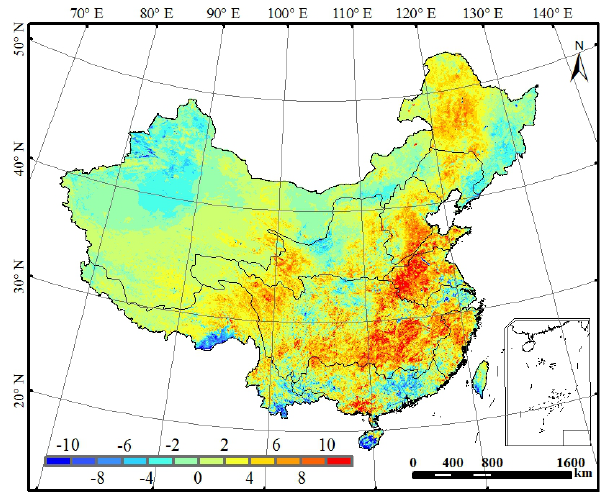
Fig. 8. Temporal trends of annual ET (mmyr − 1 ) in China from 2000 to